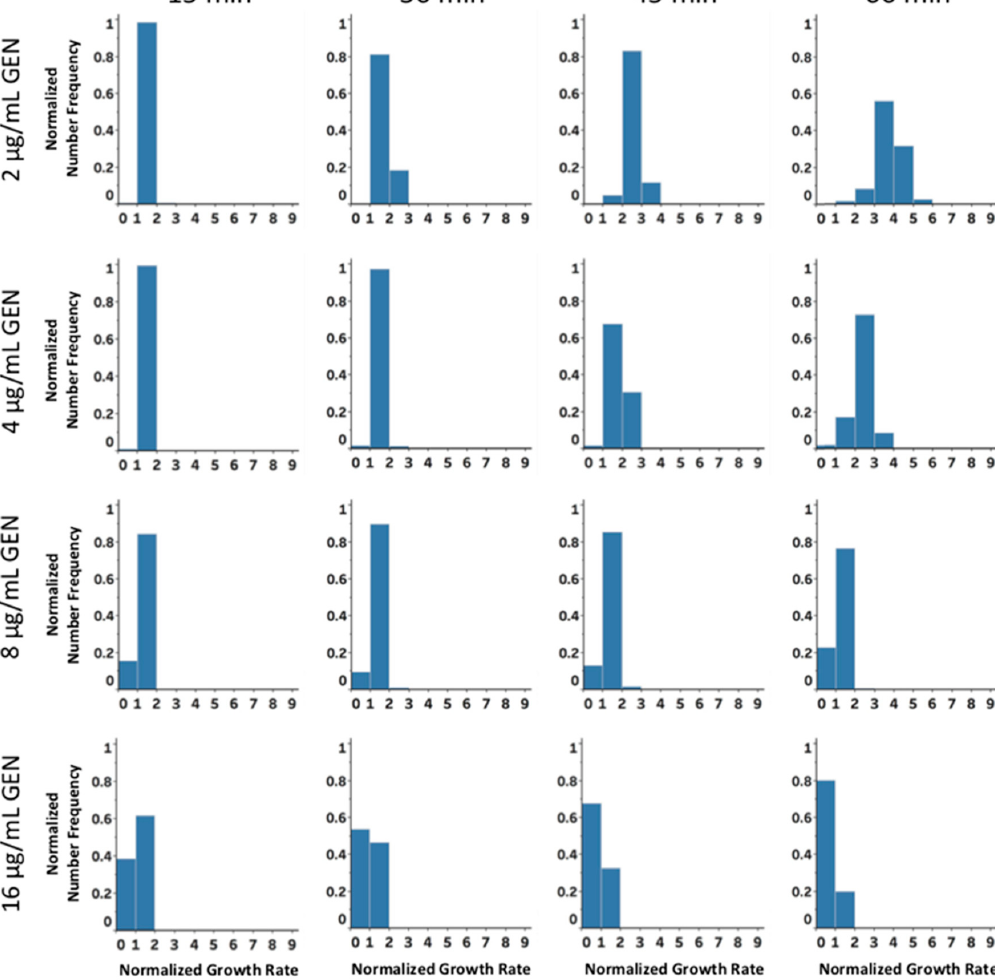
Figure 3. Minimal inhibitory concentration (MIC) determination by the reported approach. The curves were plotted by the normalized fraction of replicated cells from each treated group versus time.